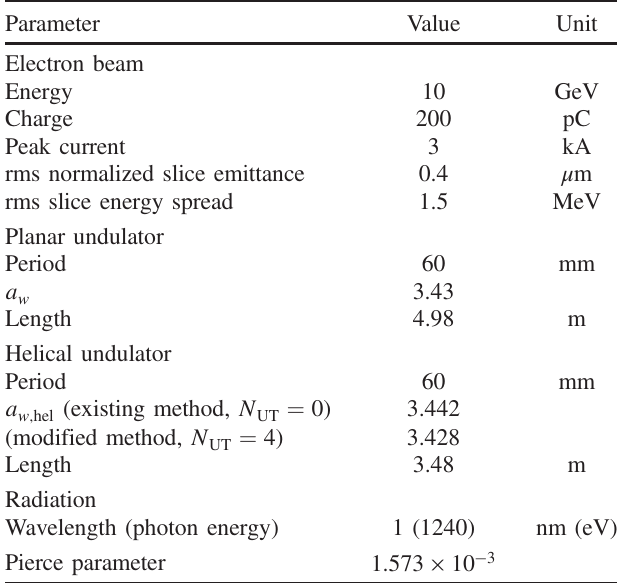
TABLE I. Main parameters used in the simulations. Parameter